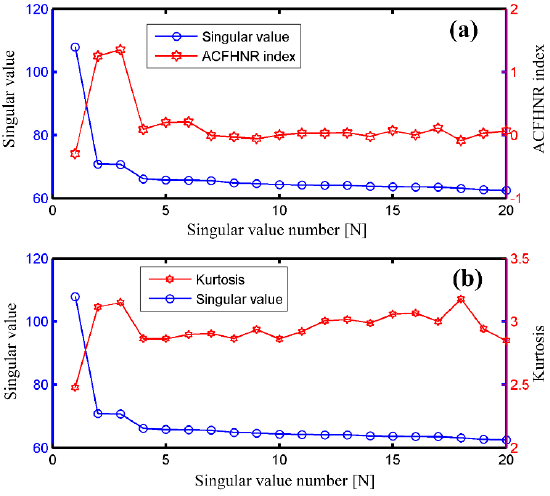
Figure 8. The relationship between the singular value and ( a ) the kurtosis or ( b ) the ACFHNR index.